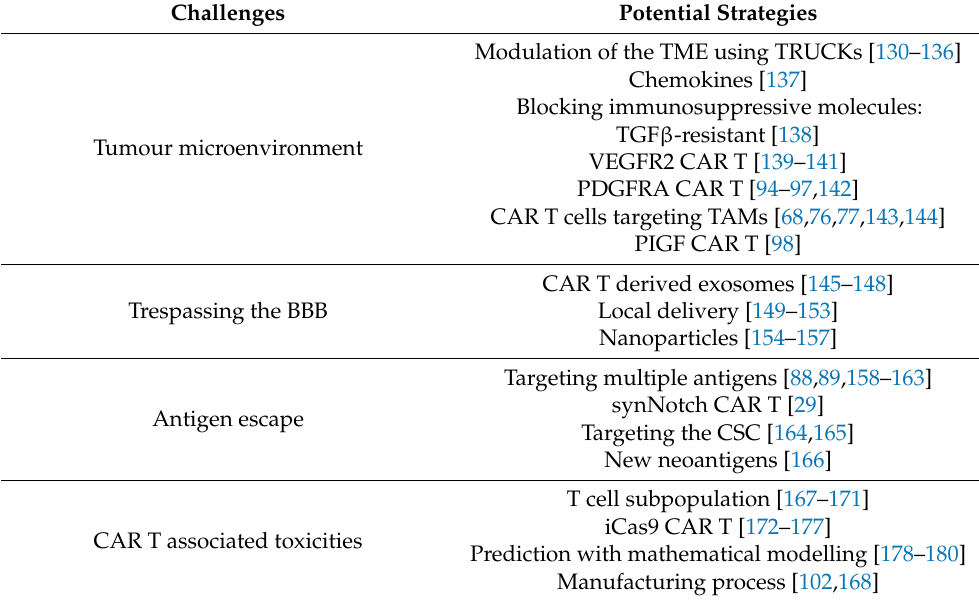
Table 3. Challenges for CAR T cell therapy in paediatric CNS tumours and overcoming